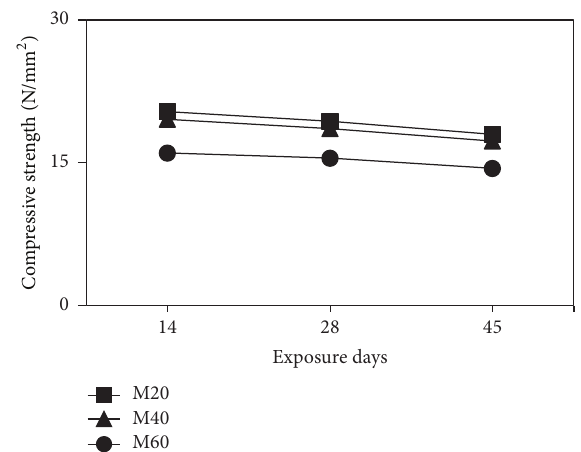
Figure 8: Density of GPC exposed to sulphuric acid solution. Figure 9: Compressive strength of GPC exposed to magnesium sulphate solution.